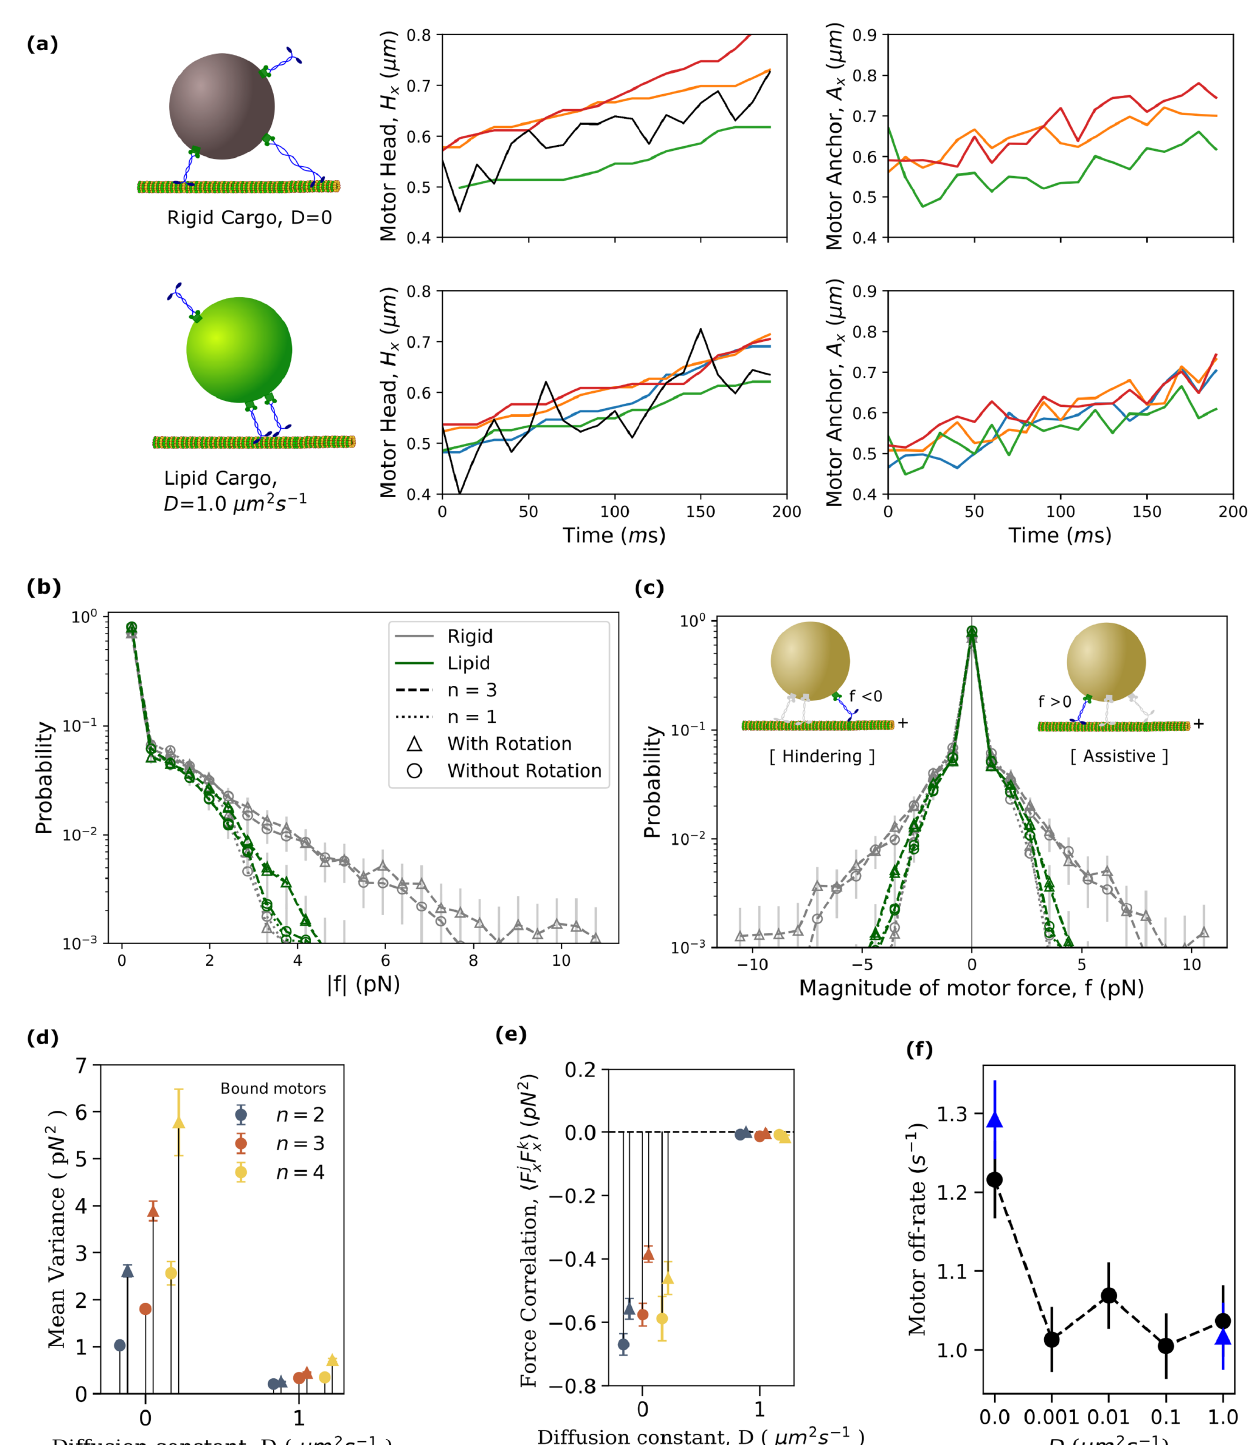
Fig 2. Surface fluidity reduces the negative interference between bound kinesin motors which leads to reduction in motor off-rate. (a) Typical trajectories for a rigid (top row) and a lipid cargo (second row). Motor head position subplots (middle column) include the x-positions of the center of mass of cargo (black lines) and head positions of motors on the microtubule (colored lines). The corresponding x-component of motor anchor positions (right column) on the cargo are also shown. (b) Distributions of the absolute magnitude of the force experienced by motors in rigid and lipid cargoes (including without cargo rotation) at a fixed number of bound motors ( n = 3). Distribution for singly bound motor carrying a rigid cargo is also shown for